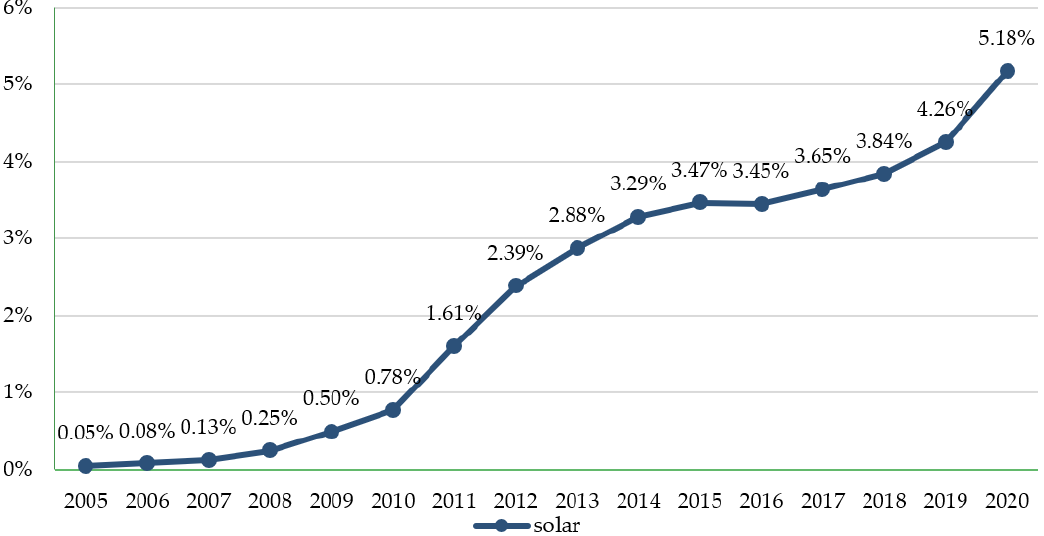
Figure 1. Share of solar energy in structure of electricity production in EU in the period 2005 – 2020. Based on data from [77].